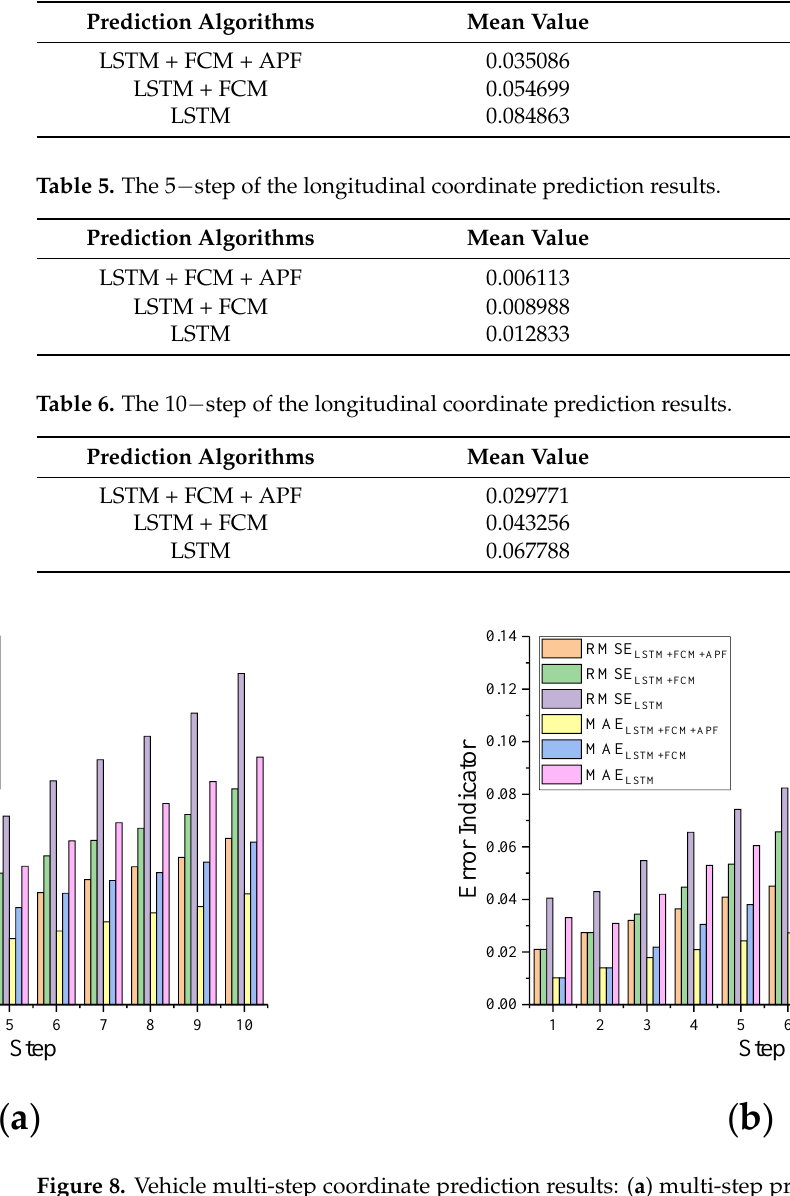
Table 4. The 10 − step of the lateral coordinate prediction results.